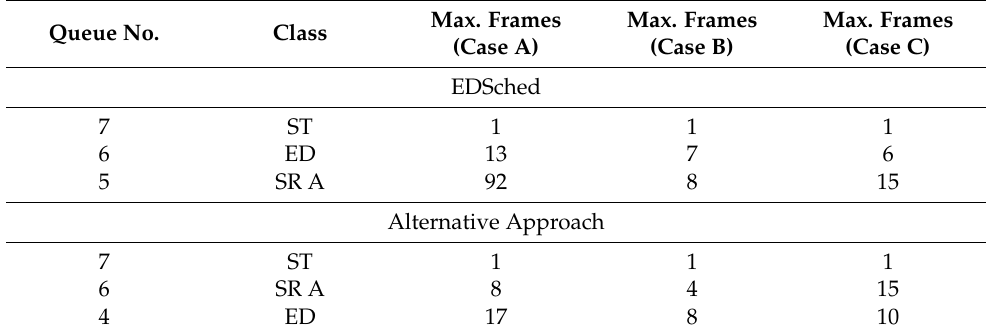
Table 4. Maximum number of frames enqueued per class at the switch port connected to the controller. Max. Queue No. Class